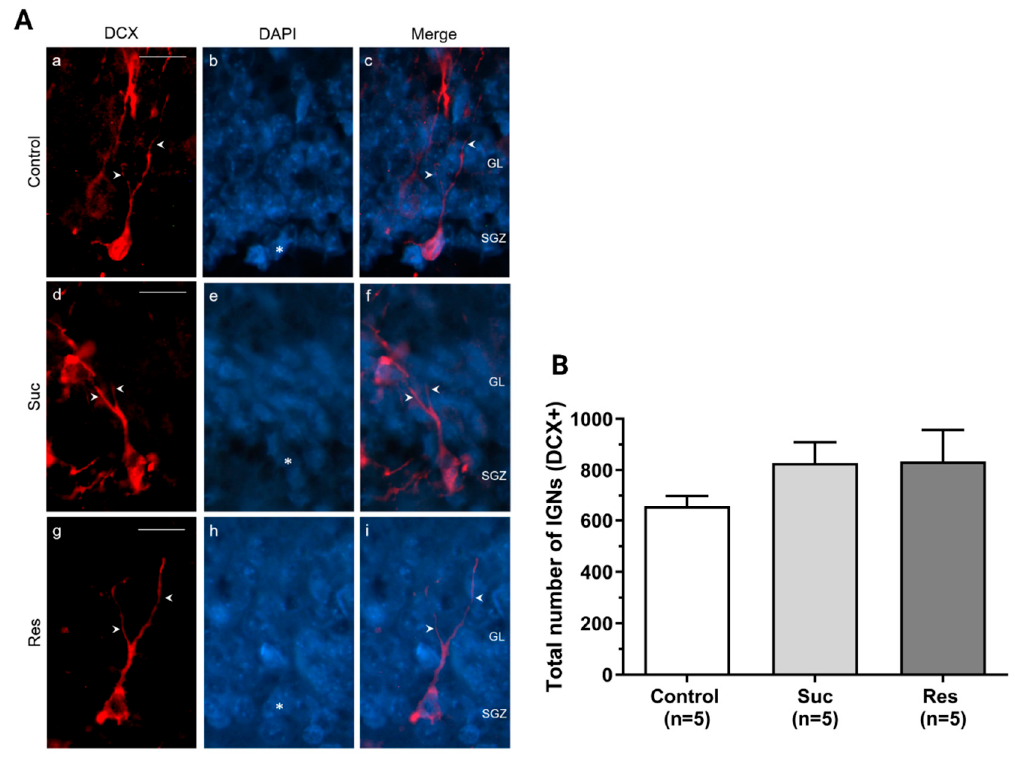
Figure 8. Sucrose consumption does not modify the number of immature granular neurons (IGNs) in the subgranular zone of the ventral dentate gyrus. ( A ) Representative photomicrographs showing the presence of IGNs (DCX+, red) and their merge with DAPI (blue) in the subgranular zone (SGZ) of ventral dentate gyrus (DG) in the control (a–c), Suc (d–f) and Res (g–i) groups. The arrowheads indicate the dendritic arborization of the IGNs typically oriented toward the granule cell layer (GL) of the DG. Arrowheads show the cell nuclei (DAPI+) that colocalized with KI67 marker. ( B ) A cell counting of IGNs located in the SGZ of the ventral DG. No significant difference was found. One-Way ANOVA. Scale bar: 20 µ